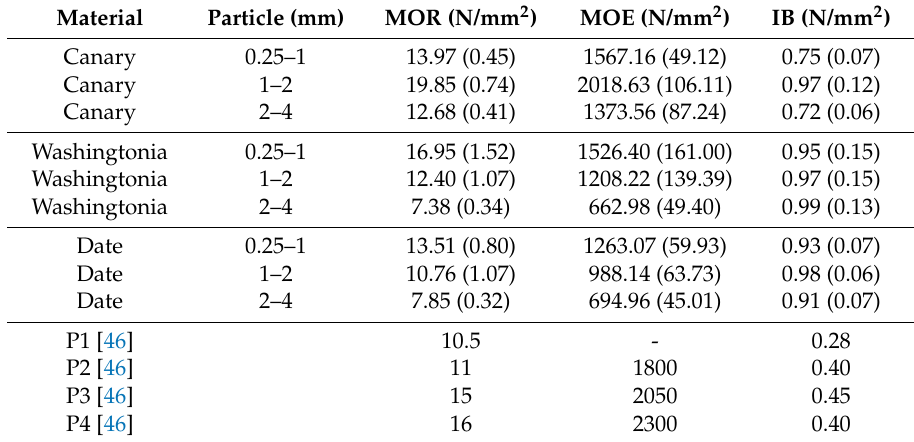
Table 3. Average mechanical properties of particleboards from different palm rachis species.